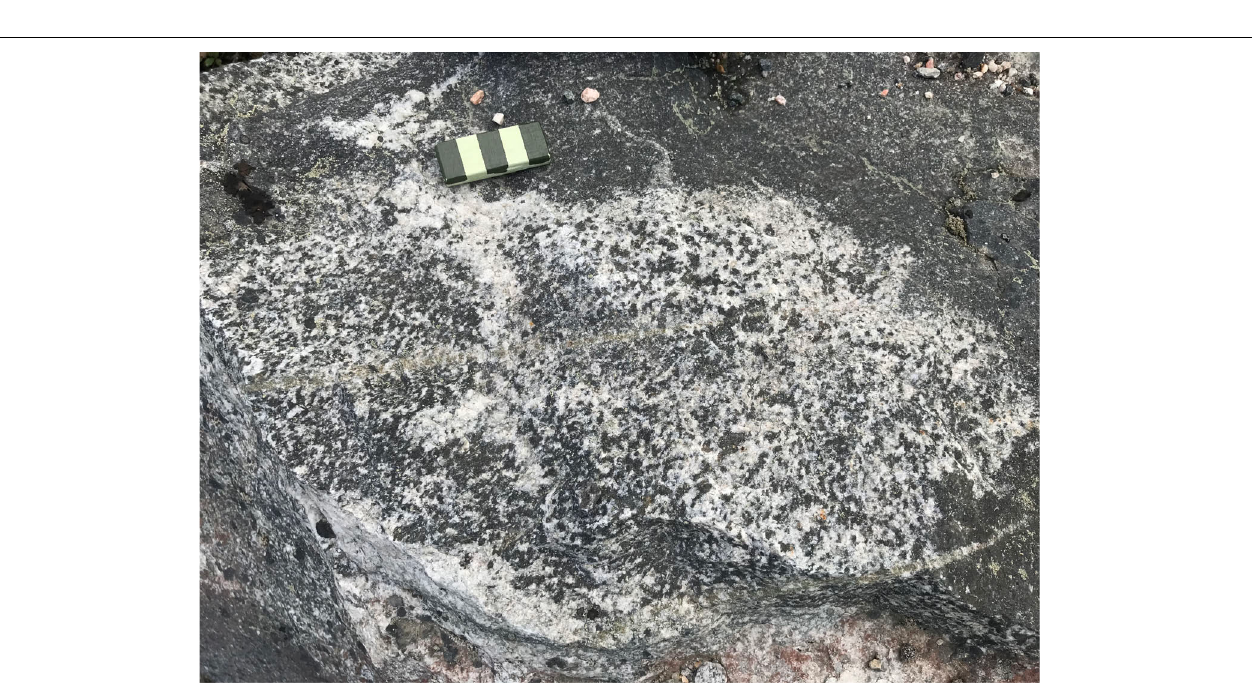
FIGURE 4 | Patch metatexite, Kilpisjärvi, NW Finland, Rommaeno Complex, Norrbotten Province. Neosome occurs as discrete coarse-grained, unsegregated patches representing slightly higher degrees of melting at low syn-anatectic strain. Length of scale 5 cm.